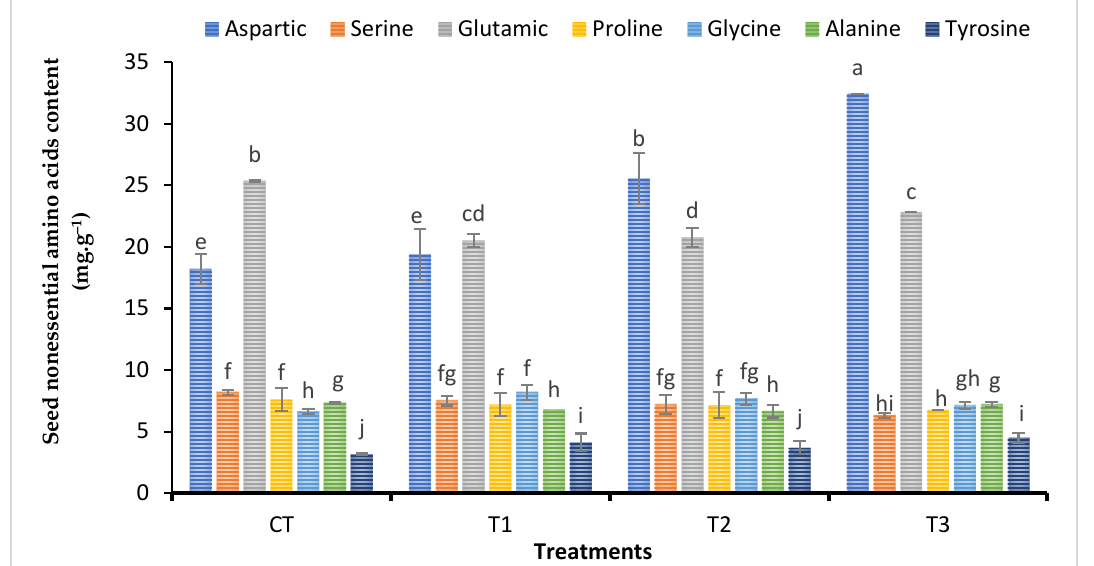
Figure 2. Impact of diverse iron sources, as foliar spray, on seed essential amino acid content of Vicia faba plants. Means of each column followed by the same letter are not statistically different according to the Duncan multiple comparison test at the 5% level. Each value is the average of 6 replicates over two seasons. Bars indicated to standard error ( ± SE). T1 = Synthesized nano-iron, T2 = Chelated iron, T3 = Iron sulfate, and CT = Control.